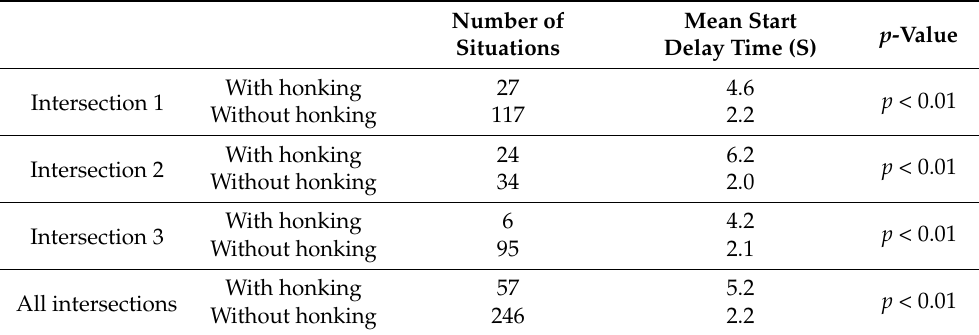
Table 9. Mean start delay times with and without horn